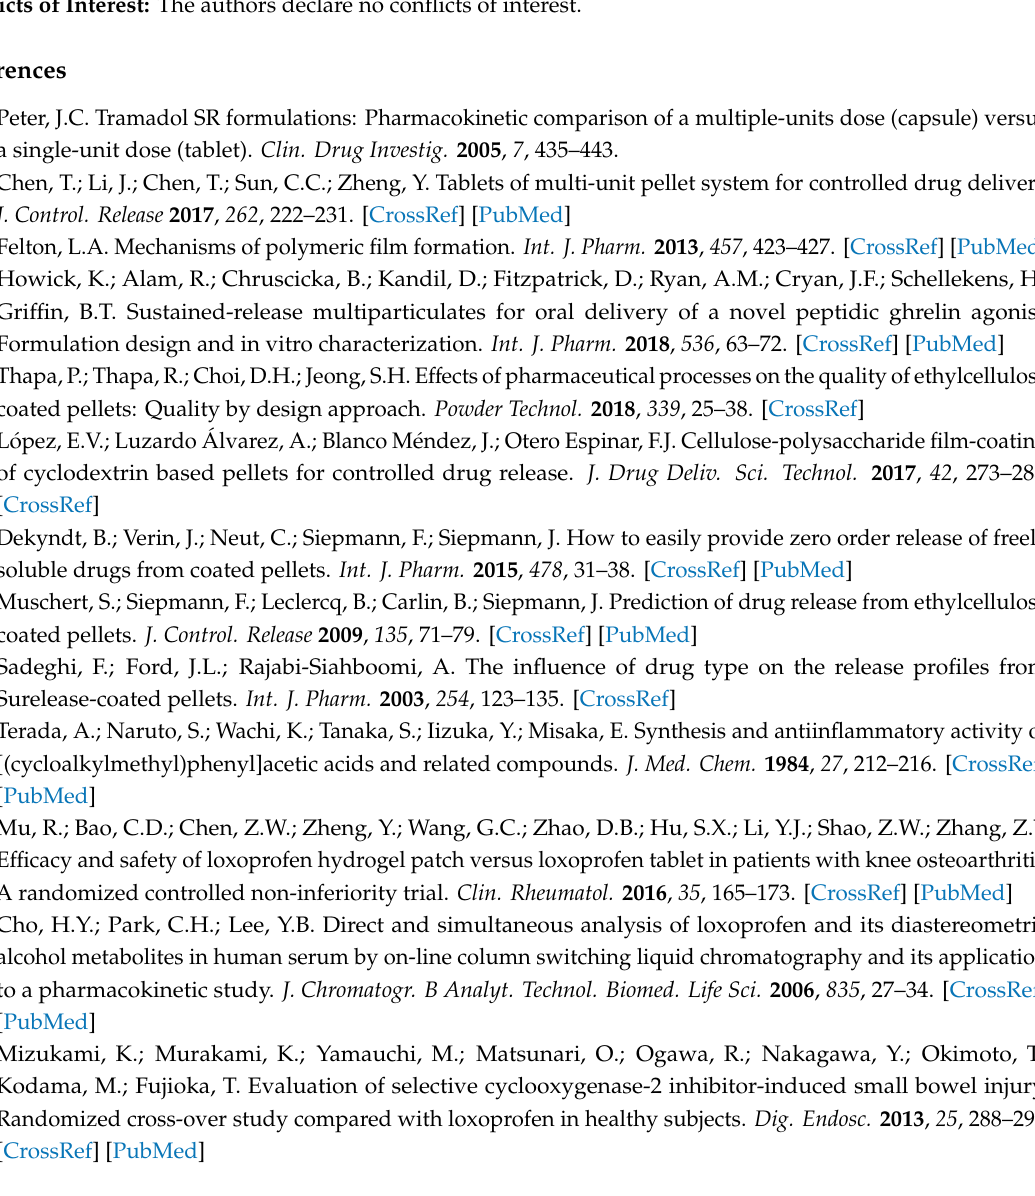
Figure S1: pH solubility profiles of loxoprofen at 25 ◦ C. Figure S2: Contour plots showing the e ff ects of ( A ) X 1 and X 2 , ( B ) X 2 and X 3 , and ( C ) X 1 and X 3 on the response Y 1 . Figure S3: Contour plots showing the e ff ects of ( A ) X 1 and X 2 , ( B ) X 2 and X 3 , and ( C ) X 1 and X 3 on the response Y 2